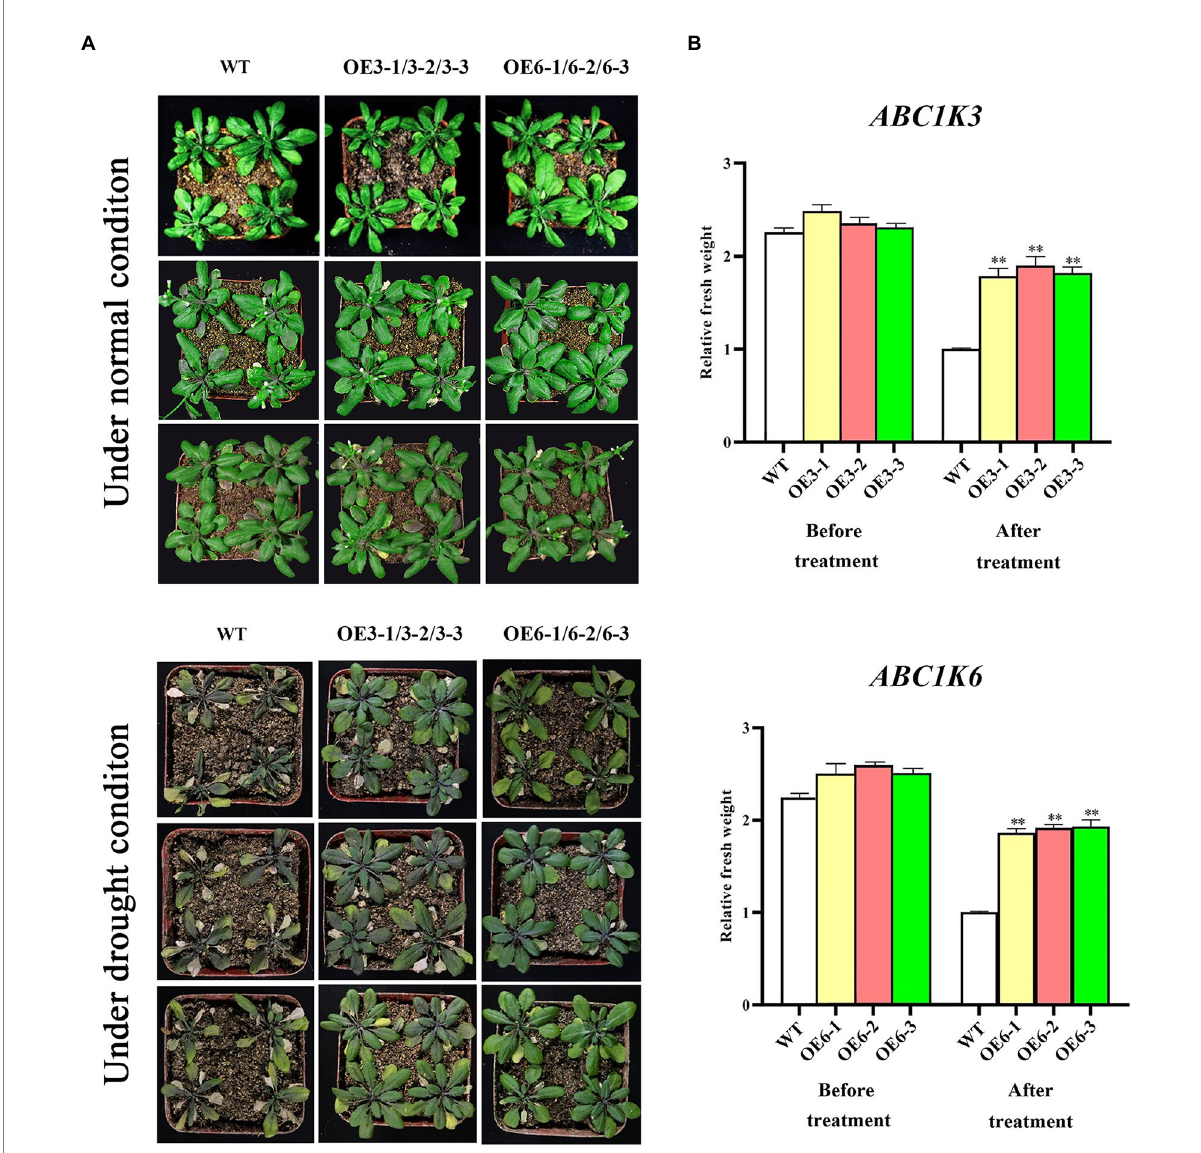
FIGURE 8 Phenotype changes of TaABC1K3 and TaABC1K6 overexpressed Arabidopsis plants under soil culture in response to drought stress. (A) Soil drought stress treatment was performed on wild-type, TaABC1K3 and TaABC1K6 overexpressed plants. (B) Comparison of fresh weight of wild- type, TaABC1K3 , and TaABC1K6 overexpressed plants under drought treatment and normal conditions. Statistically significant differences between control group and treatment group were calculated by an independent Student’s t -tests: ** p <